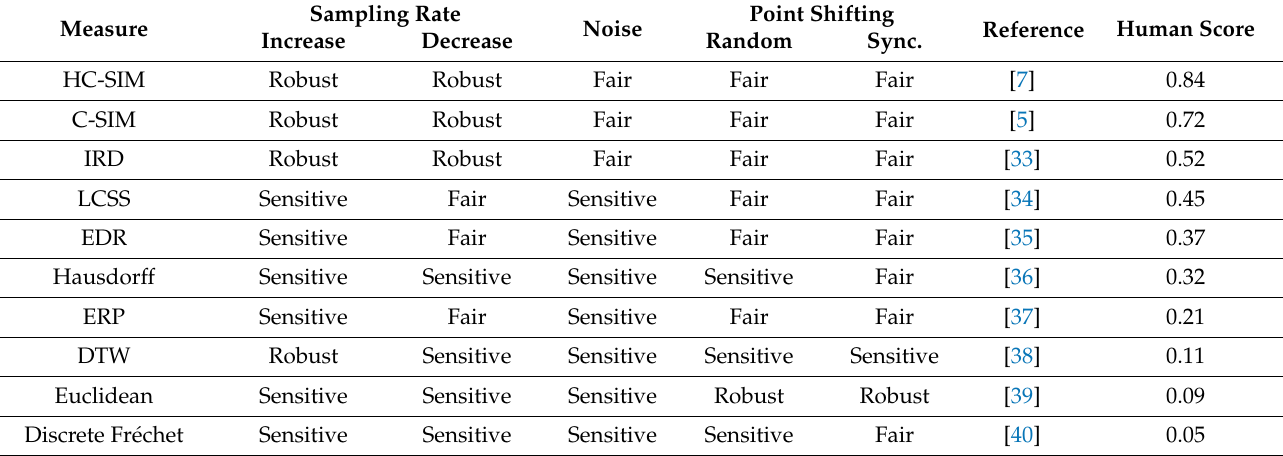
Table 1. Summary of the considered distance measures. The properties are taken from [5], except IRD and HC-SIM, which we added here using our subjective understanding. Human score is the correlation of the measure with human evaluation made in [7]. Most of the measures are also found in the web tool: http://cs.uef.fi/mopsi/routes/similarityApi/demo.php (accessed on 25 November 2021).